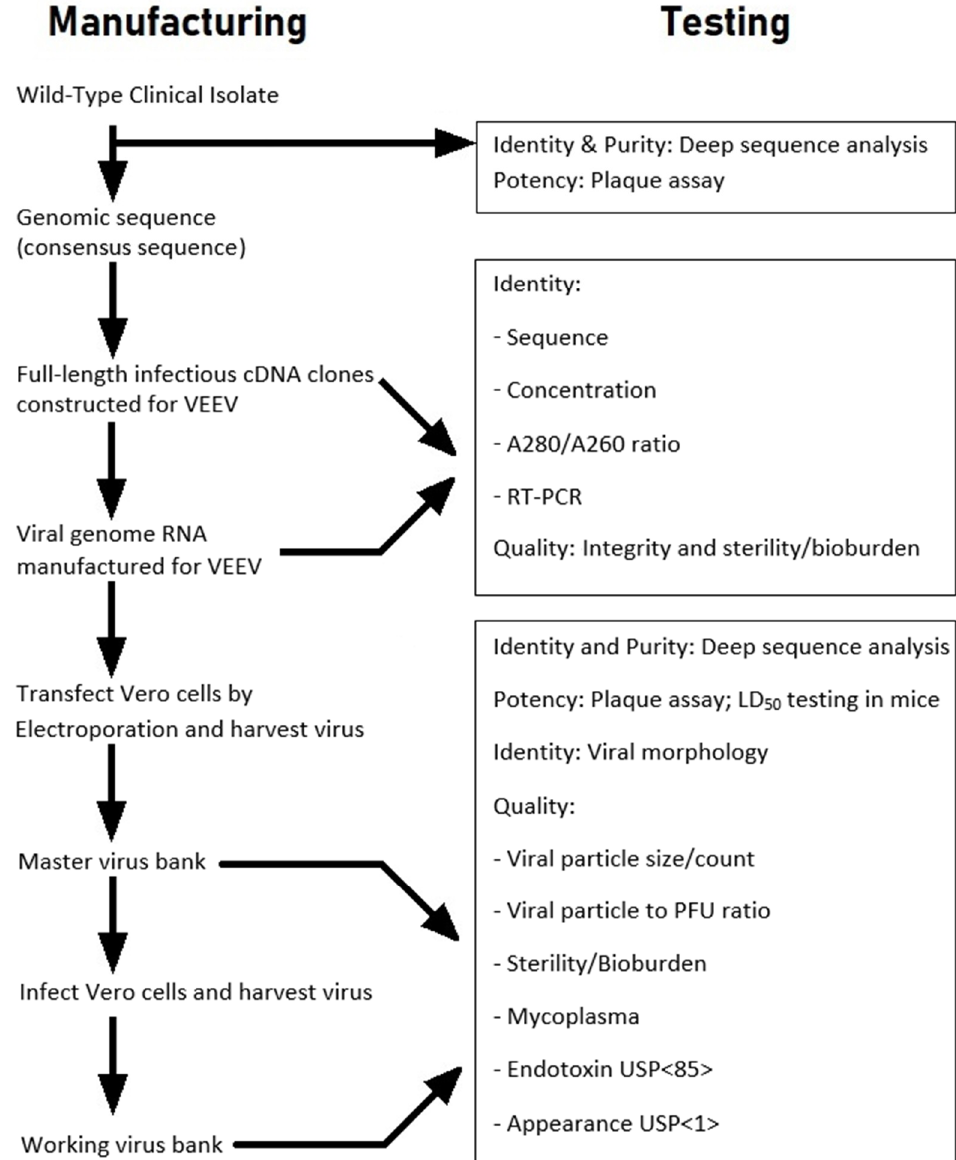
Figure 2. Process flow diagram for initial assessment and manufacturing cloned (cDNA) VEEV TrD and INH 9813 strains for challenge material.